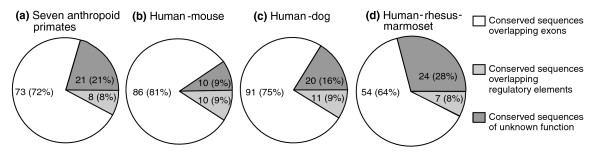
Primate comparisons identify known functional elements and conserved non-coding sequences in genomic intervals encompassing LXRα, SREBF1, CYP7A1, LDLR, ABCG5, ABCG8, APOE cluster, APOCIII cluster, and HMGCR. The number of evolutionarily conserved sequences (p value ≤ 0.1) overlapping exons, previously known regulatory elements and unannotated regions (new predictions) in the eight loci are shown for the following species sets: (a) seven anthropoid primates, (b) human-mouse, (c) human-dog and (d) human-rhesus-marmoset. Percentages were calculated by dividing the number of conserved sequences of each type by the total number of conserved elements (× 100).